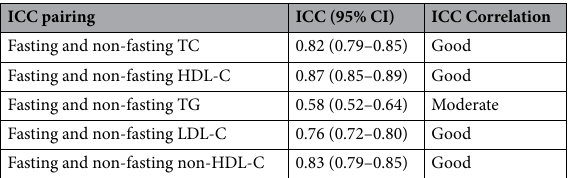
Table 3. Intraclass correlation (ICC) agreement of fasting and non-fasting lipids. ICC value ≥ 0.75 indicates good corelation 24 .